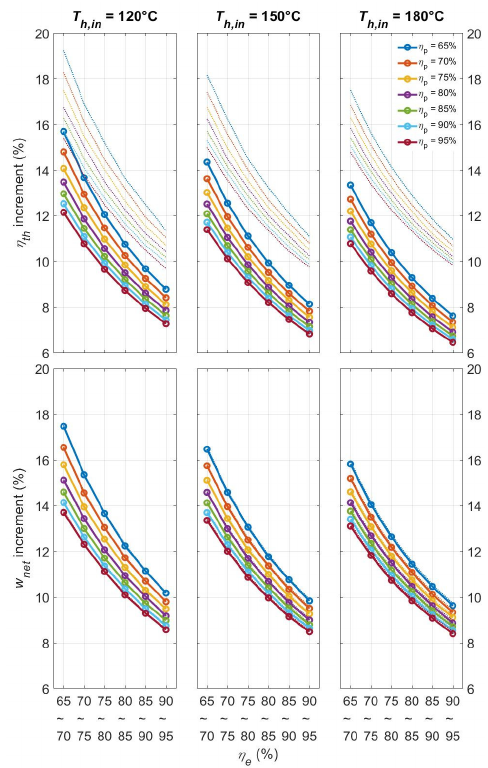
Figure 12. 𝜂 (cid:3047)(cid:3035) and 𝑤 (cid:3041)(cid:3032)(cid:3047) increments of the recuperative cycle at the design point resulting from Figure 12. η th and w net increments of the recuperative cycle at the design point resulting from enhancing 𝜂 (cid:3032) (the dotted lines represent the values of the simple cycle in Figure 7). enhancing η e (the dotted lines represent the values of the simple cycle in Figure